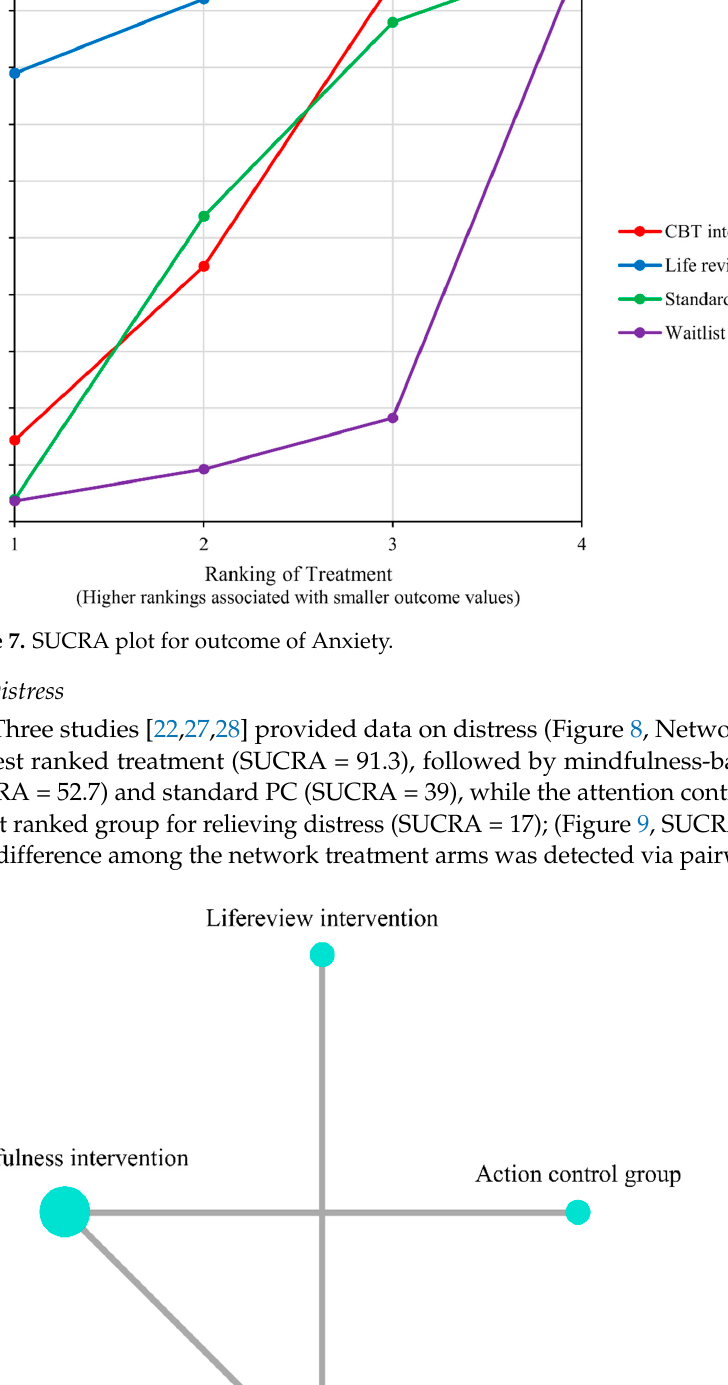
Figure 6. Network plot for outcome of Anxiety.